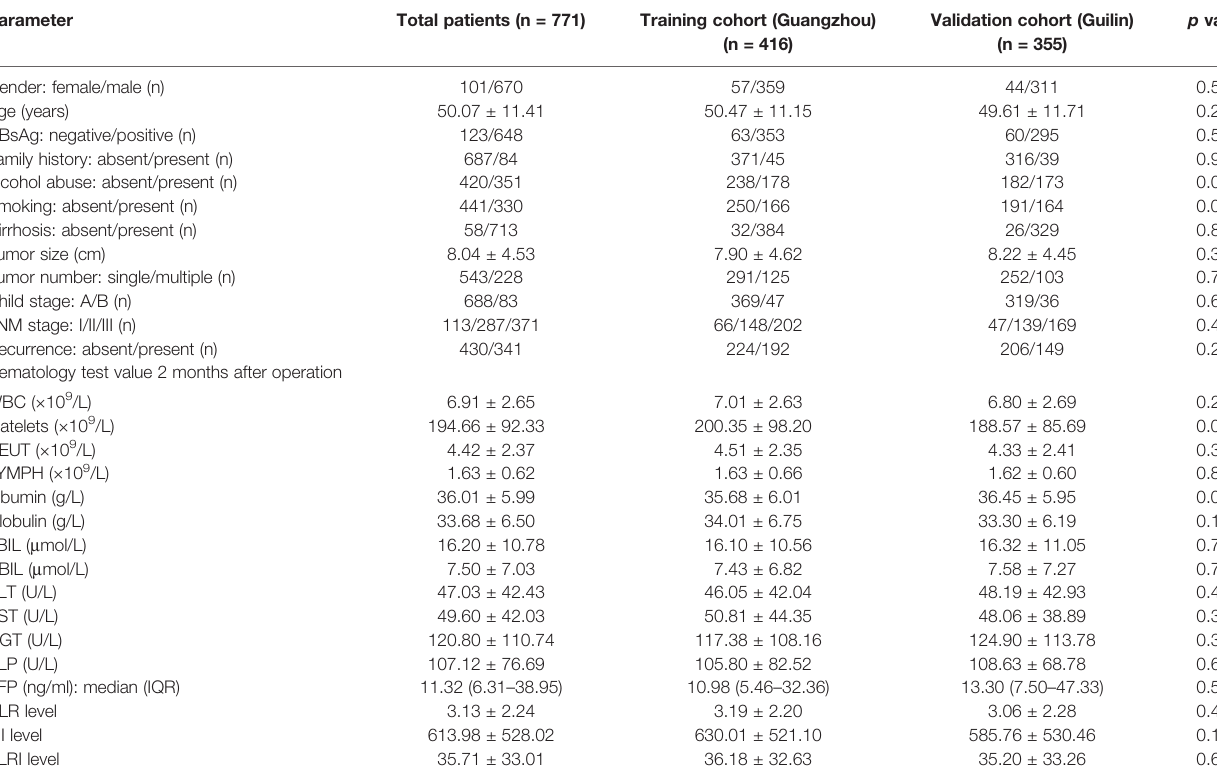
TABLE 1 | Comparison of clinicopathological characteristics of two groups ’ patients. Parameter